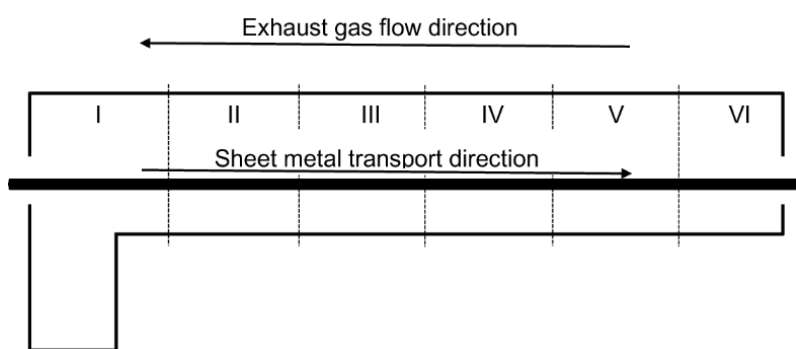
Figure 1. Construction scheme of the tunnel furnace with combustion zones I–VI. Table 1. Technical parameters of tunnel furnace.